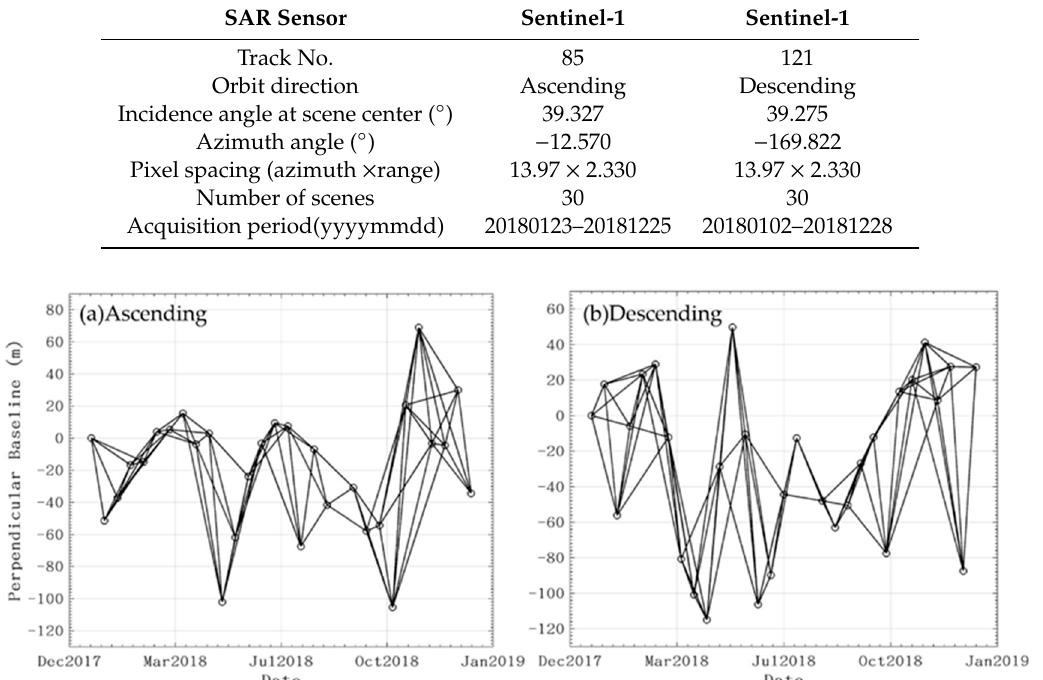
Figure 2. The distributions of temporal and perpendicular baselines of ascending and descending offset pairs used in this study: ( a ) shows the offset pairs generated by ascending Sentinel-1 data; ( b ) shows the offset pairs generated by descending Sentinel-1 data.